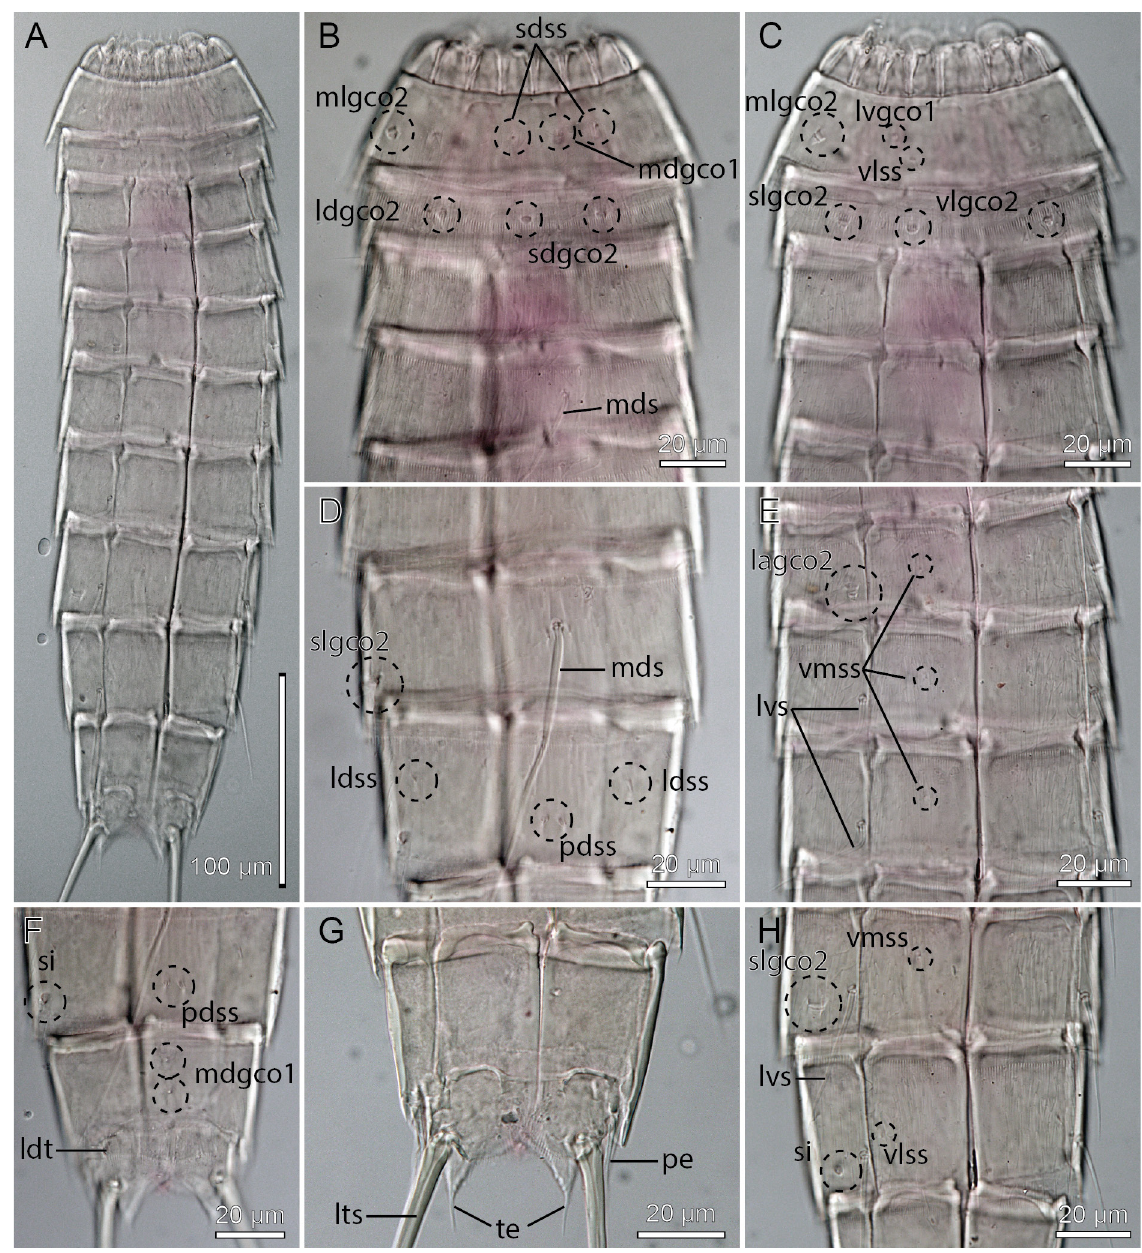
Fig. 3. Light micrographs showing overviews and details of male holotype of Echinoderes anniae sp. nov. (NHMD-226483). A . Ventral overview. B . Segments 1 to 4, dorsal view. C . Segments 1 to 4, ventral view. D . Segments 8 to 9, dorsal view. E . Segments 5 to 7, ventral view. F . Segments 9 to 11, dorsal view. G . Segments 10 to 11, ventral view. H . Segments 8 to 9, ventral view. Abbreviations: lagco2 = lateral accessory glandular cell outlet type 2; ldgco2 = laterodorsal glandular cell outlet type 2; ldss = laterodorsal sensory spot; ldt = laterodorsal tube; lts = lateral terminal spine; lvgco1 = lateroventral glandular cell outlet type 1; lvs = lateroventral spine; mdgco1 = middorsal glandular cell outlet type 1; mds = middorsal spine; mlgco2 = midlateral glandular cell outlet type 2; pdss = paradorsal sensory spot; pe = penile spines; sdgco2 = subdorsal glandular cell outlet type 2; sdss = subdorsal sensory spot; si = sieve plate; slgco2 = sublateral glandular cell outlet type 2; te = tergal extensions; vlgco2 = ventrolateral glandular cell outlet type 2; vlss = ventrolateral sensory spot; vmss = ventromedial sensory